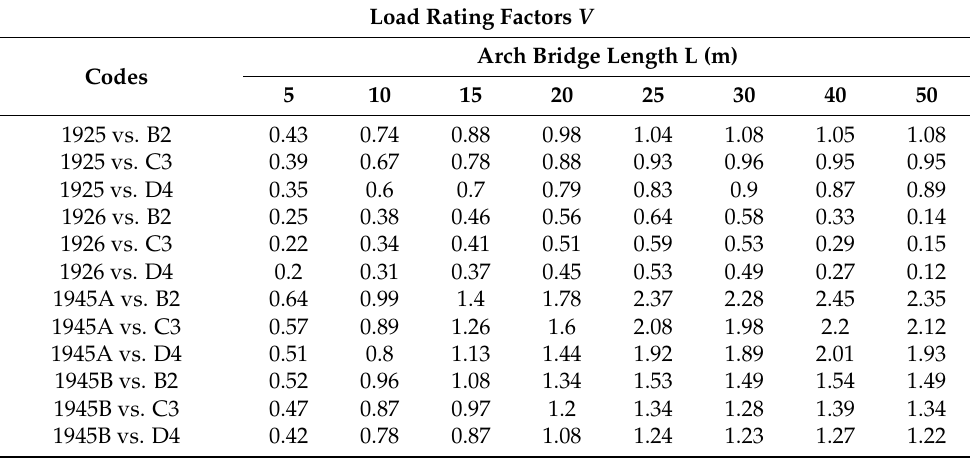
Table 4. Load Rating Factors V for the 1925, 1926, 1945A, and 1945B design loads, and the B2, C3, and D4 lines, with dynamic